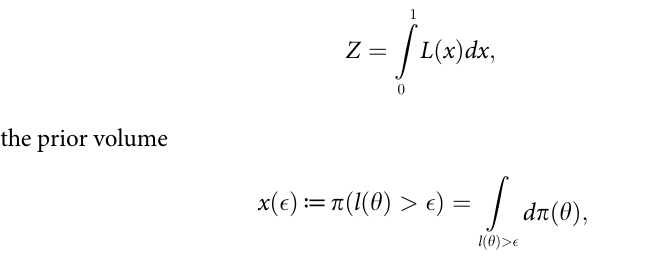
R 1 L ð x Þ dx over the prior volume x . 0